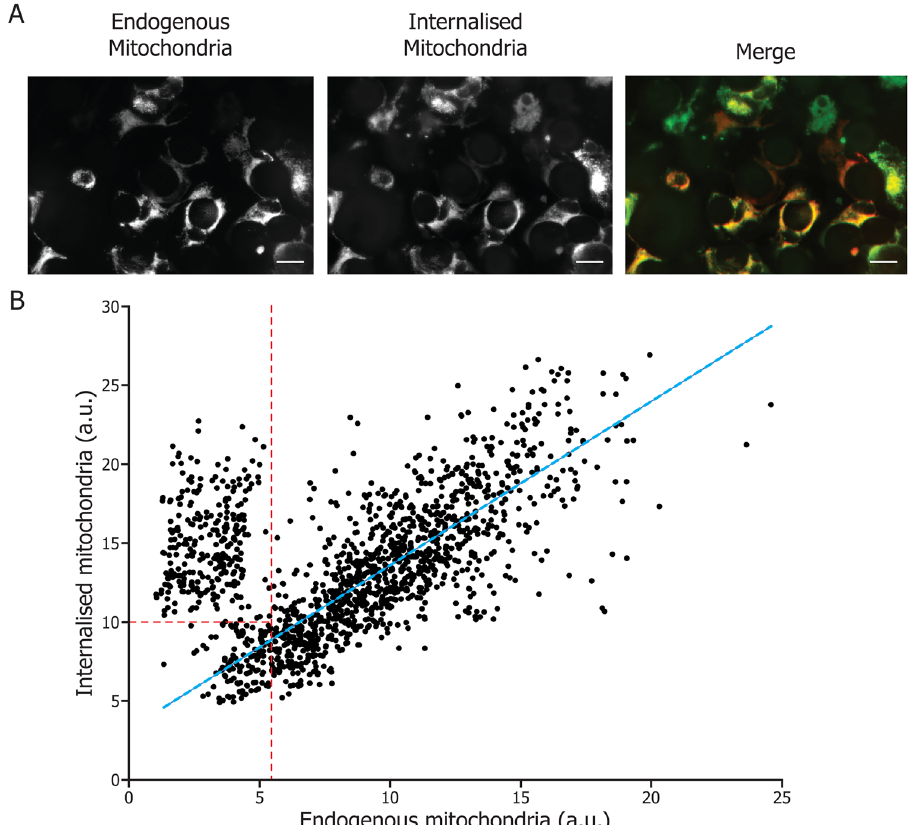
Figure 1. Endogenous mitochondrial mass in FECD cells influences mitochondrial internalization. ( A ) Mitochondrial mass markers (mitotracker) were used to label exogenous internalized (green) and endogenous mitochondria (red). ( B ) Both mitotracker signals were plotted, each dot representing a single cell. The mitochondrial mass appeared to be distributed according to two distinct clusters that could be arbitrarily separated by the two red dotted lines drawn in Figure, the horizontal red dotted line at 10 a.u. illustrating the internalized mitochondria threshold and the vertical red dotted line representing the 27% lowest endogenous mitochondrial mass level (5.2 a.u.). A strong positive correlation is found between the amounts of endogenous and exogenous mitochondria in the cells outside the red dotted line enclosed area (R2 = 0.66; ρ = 0.66; p < 0.001). Scale bar = 40 µm. Experiments were performed with 3 explants from 3 FECD patients (1555 cells